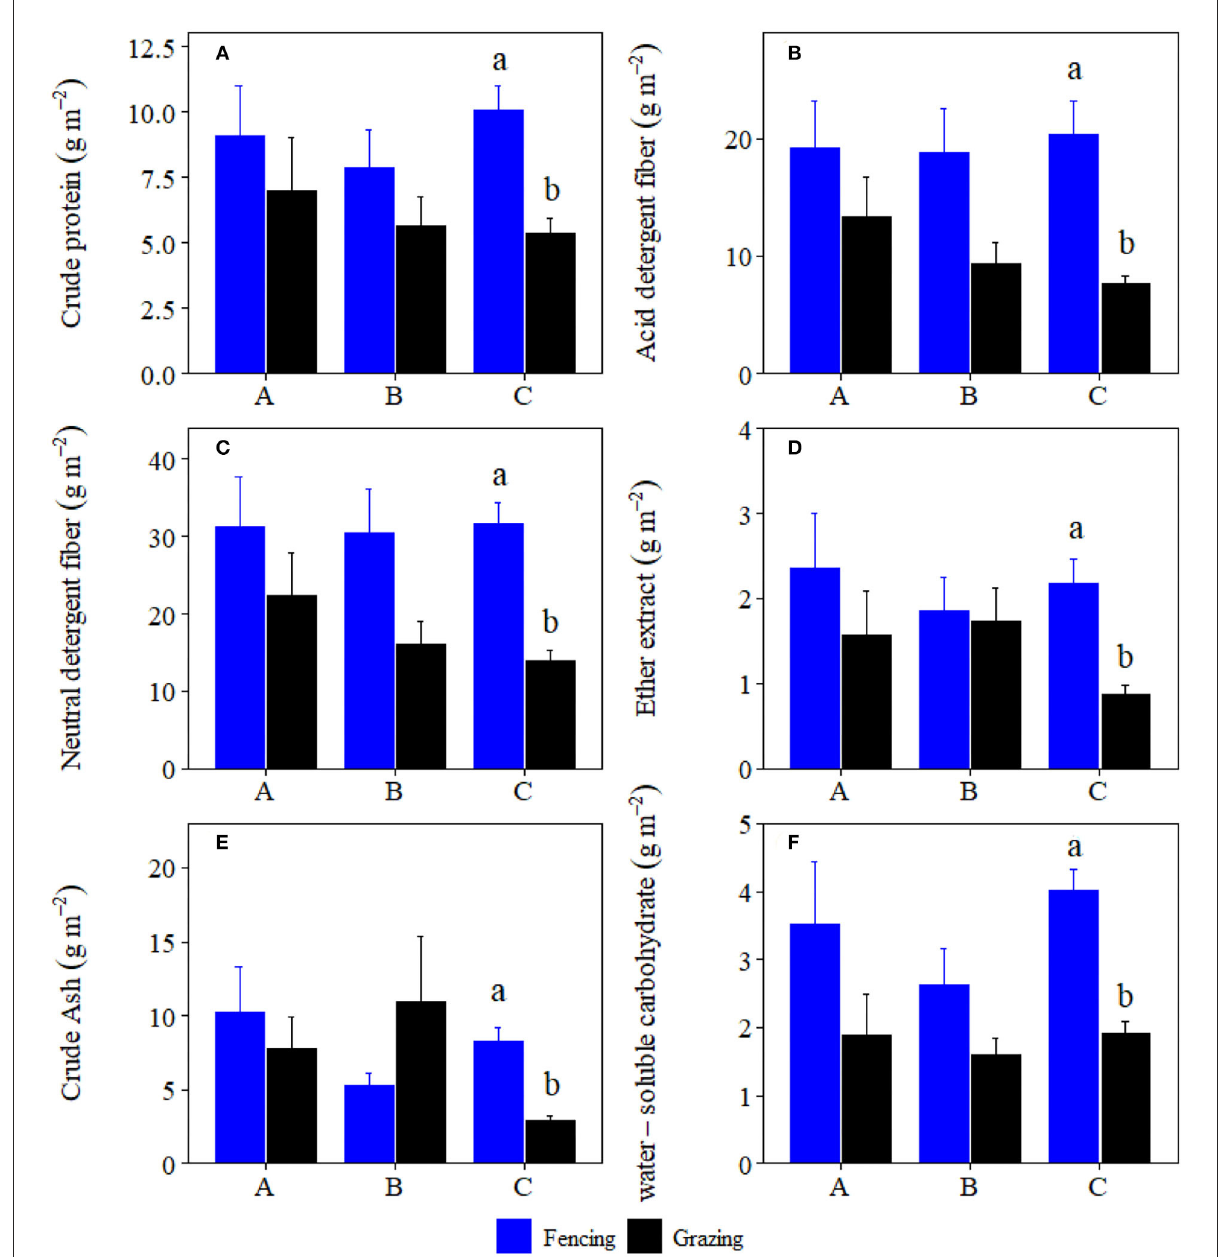
FIGURE1 Comparisons of plant community (A) crude protein, (B) acid detergent fiber, (C) neutral detergent fiber, (D) ether extract, (E) crude ash, and (F) water-soluble carbohydrate storages (mean ± SE) between the fencing and grazing conditions in three alpine grasslands located at site A–C, respectively. Different letters indicated significant difference for nutrition storages between the fencing and grazing conditions at p < 0.05